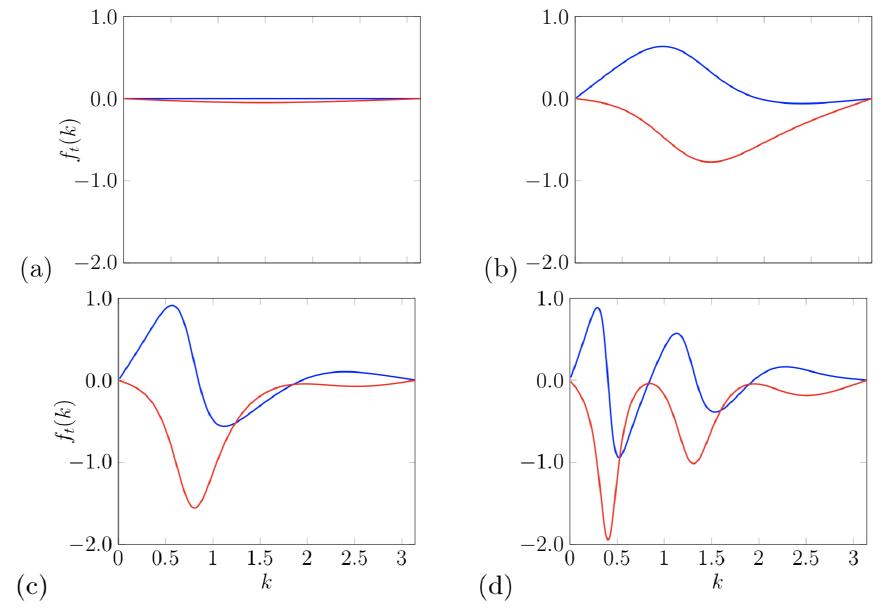
( k ) for a quantum quench from h ( 0 ) = 0.1 to h ( t ) = 0.9 for Figure 2: Amplitude f t t > 0 at times (a) t = 0; (b) t = 0.5; (c) t = 1; (d) t = 2. The real and imaginary parts are shown in blue and red